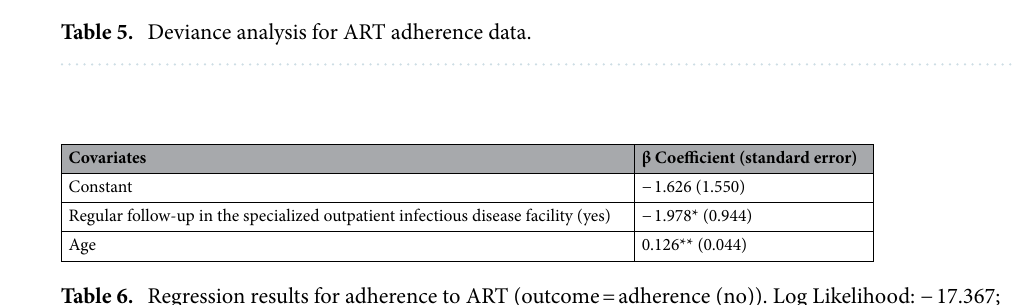
Table 6. Regression results for adherence to ART (outcome = adherence (no)). Log Likelihood: − 17.367; Akaike Information Criterion: 40.733. * p -value < 0.05; ** p -value <